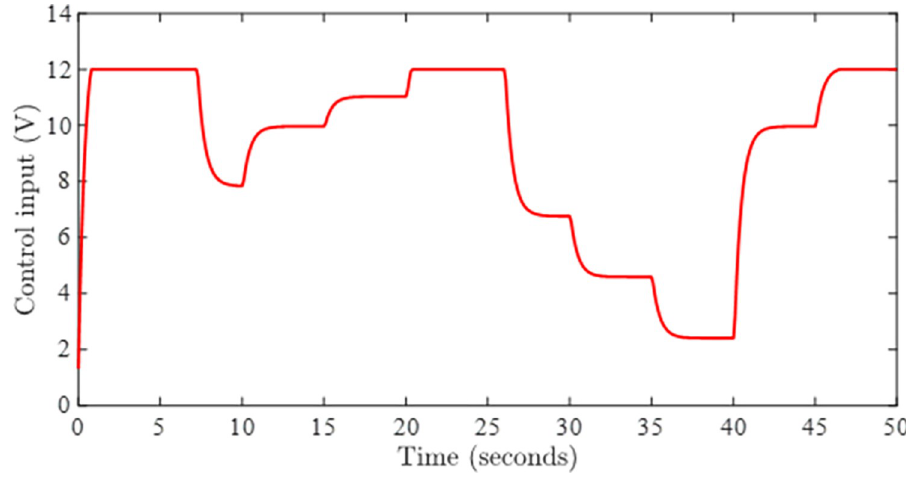
Fig 3. Control signal without